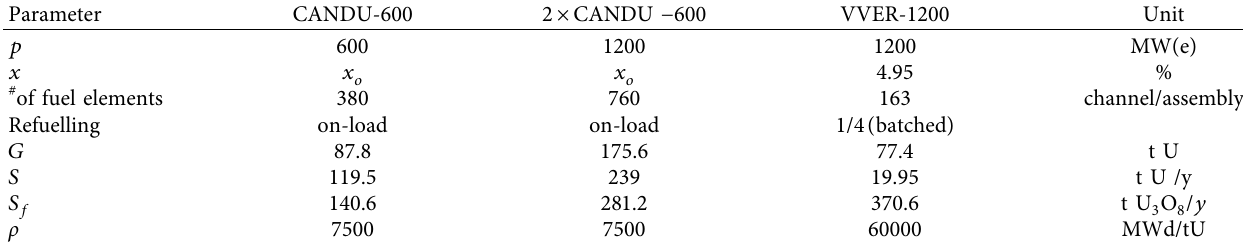
Table 2: Fuel core data for standard NPP’s, [14,